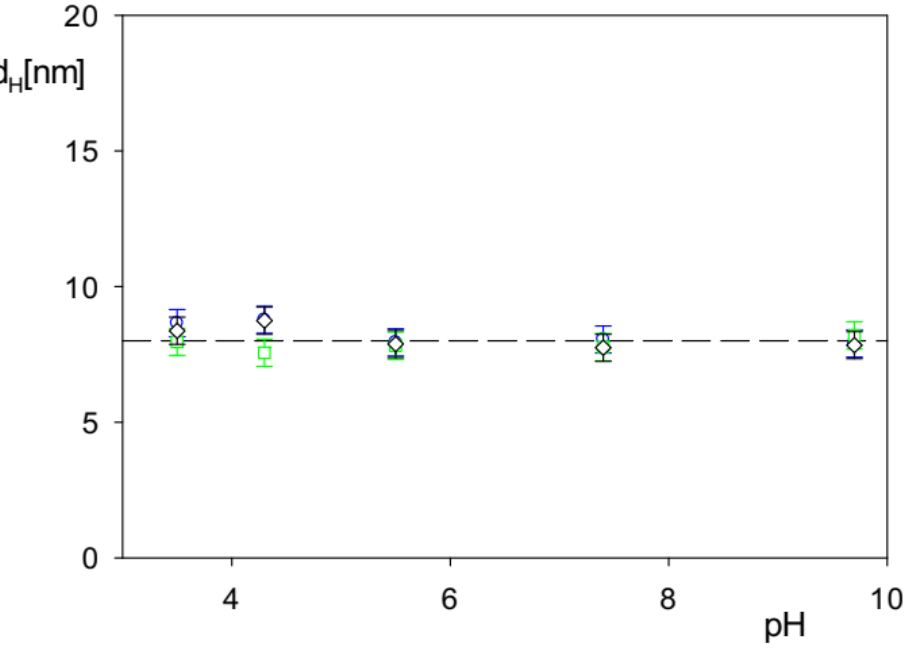
Figure 1. Dependence of the hydrodynamic diameter of human serum albumin (HSA) molecules on pH calculated from Equation (2): ( (cid:3) ) 0.15 M, ( ♦ ) 5 × 10 − 2 M, ( average value of the hydrodynamic diameter equal to 7.5